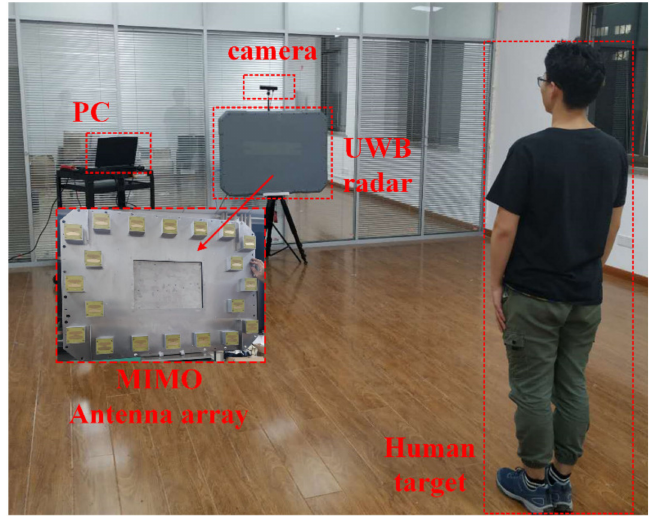
Figure 4. Dataset collection scenario.